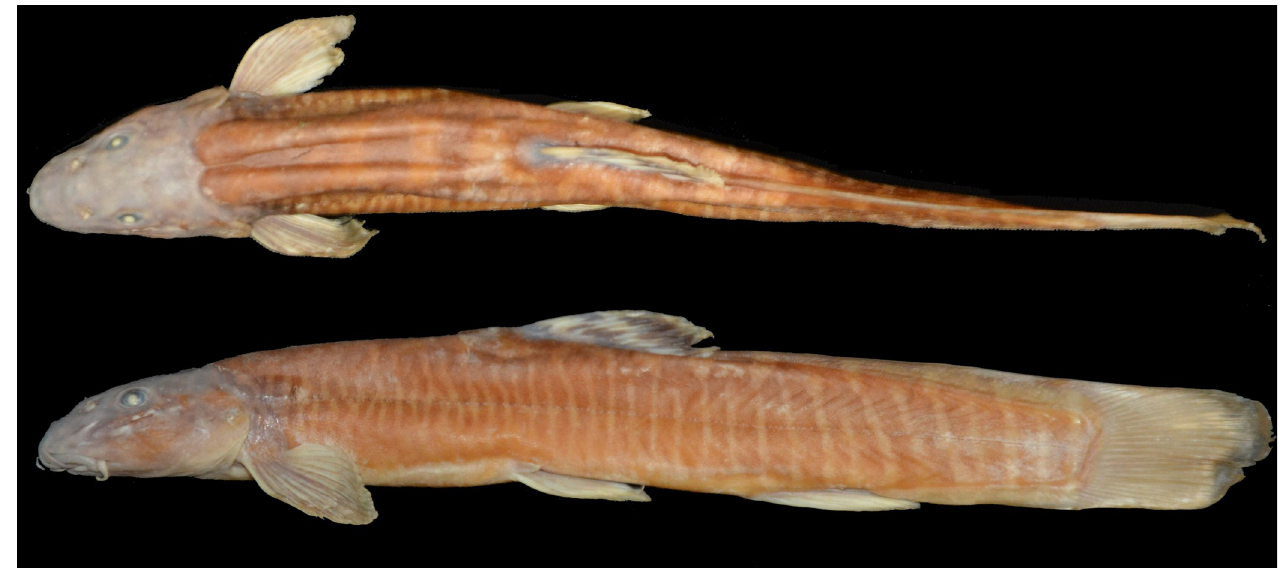
Fig 1. Left lateral and dorsal views of Homatula geminusclathratus . Holotype SWFU 0309250, 131.8 mm SL; China: Yunnan Prov.: Pu’er City: Jingdong Co.: Wenjing